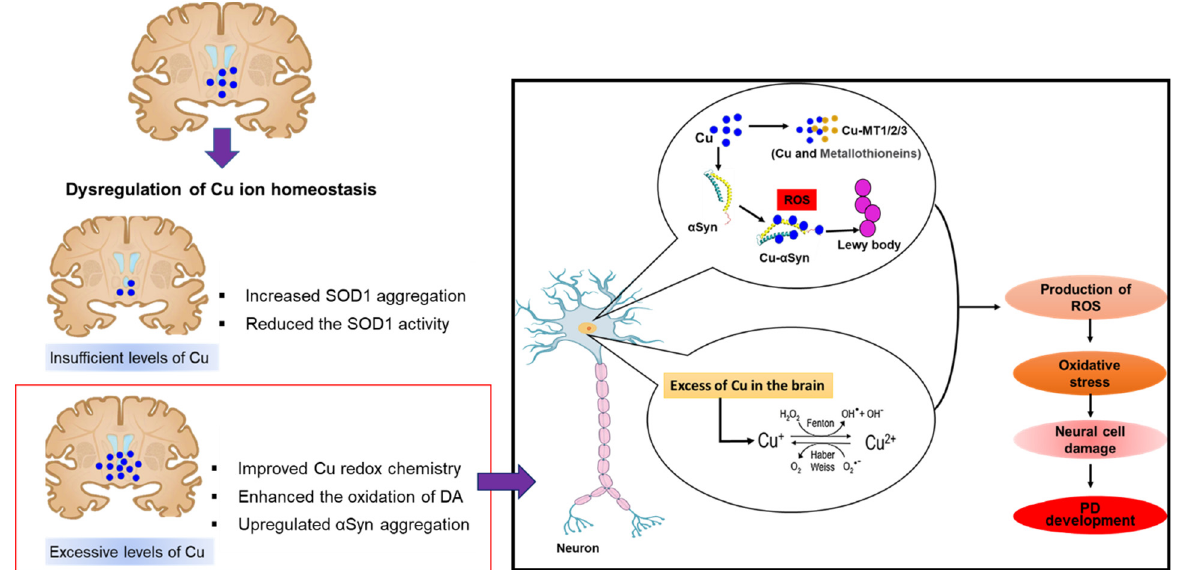
Figure 4. Dysregulation of Cu ion homeostasis in PD. Excessive levels of Cu improved dopamine (DA) oxidation, upregulated α -synuclein ( α Syn) aggregation, and formation of Lewy bodies. Excess Cu levels in the brain take part in Fenton chemistry as a catalyst to produce free radicals. Both processes lead to ROS production causing dopaminergic neuronal death and PD.